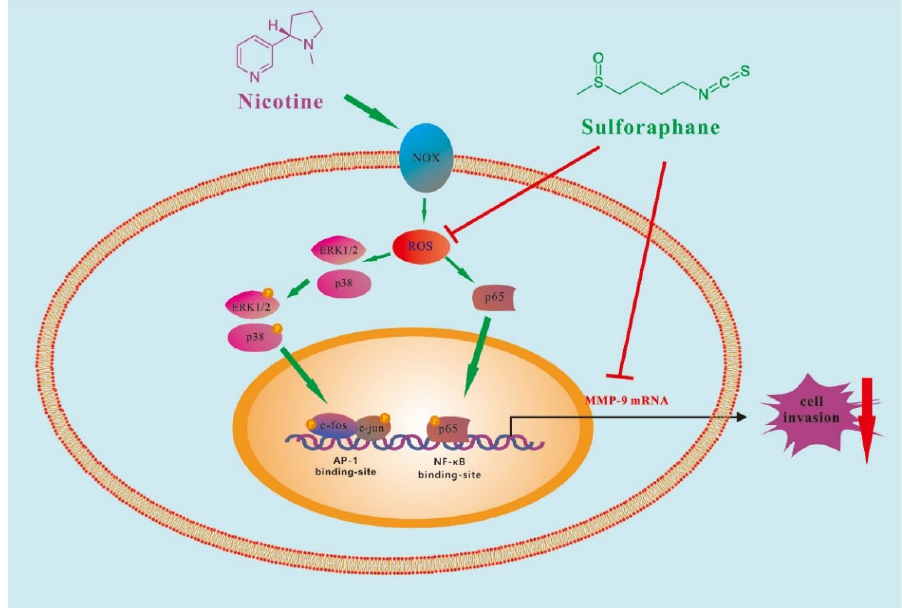
Figure 7. Schematic representation of the mechanism underlying the inhibition of nicotine-induced MMP-9 expression by sulforaphane in AGS cells. Sulforaphane inhibits nicotine-induced MMP-9 expression via suppression of the ROS/MAPKs(p38 MAPK, Erk1/2)/AP-1 and ROS/NF- κ B signaling pathways, which in turn attenuate AGS cell invasiveness.